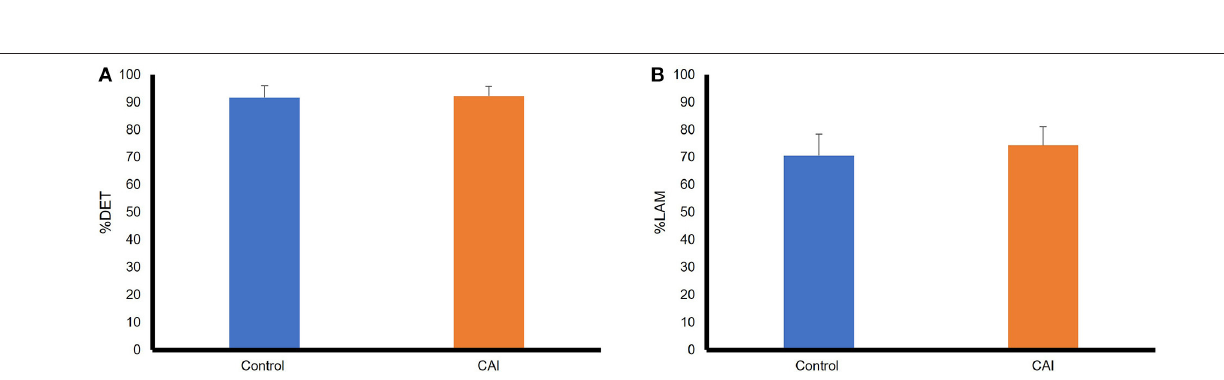
slightly higher in the control group than that in the CAI group, but the difference did not reach a statistical significance, t(22) = − 1.17, p = 0.26, Cohen’s d = − 0.4, a small